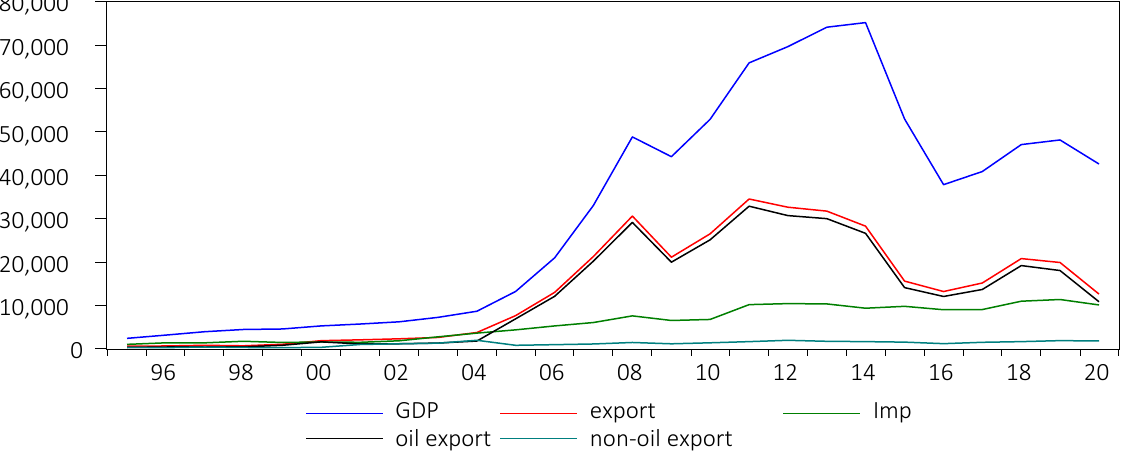
Figure 1. Dynamics of GDP, exports, and imports of